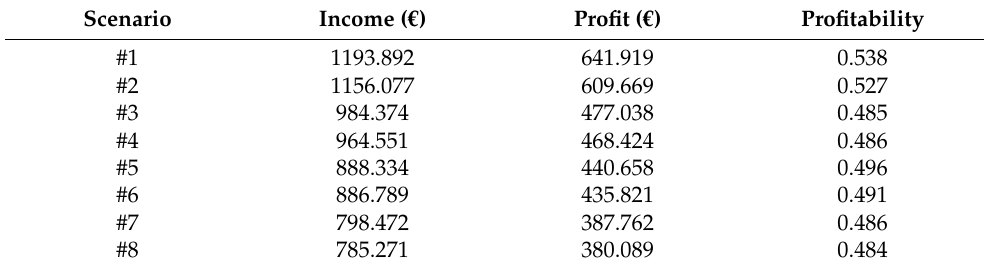
Table 5. Income, profit, and profitability for the various scenarios for 2 January 2019.